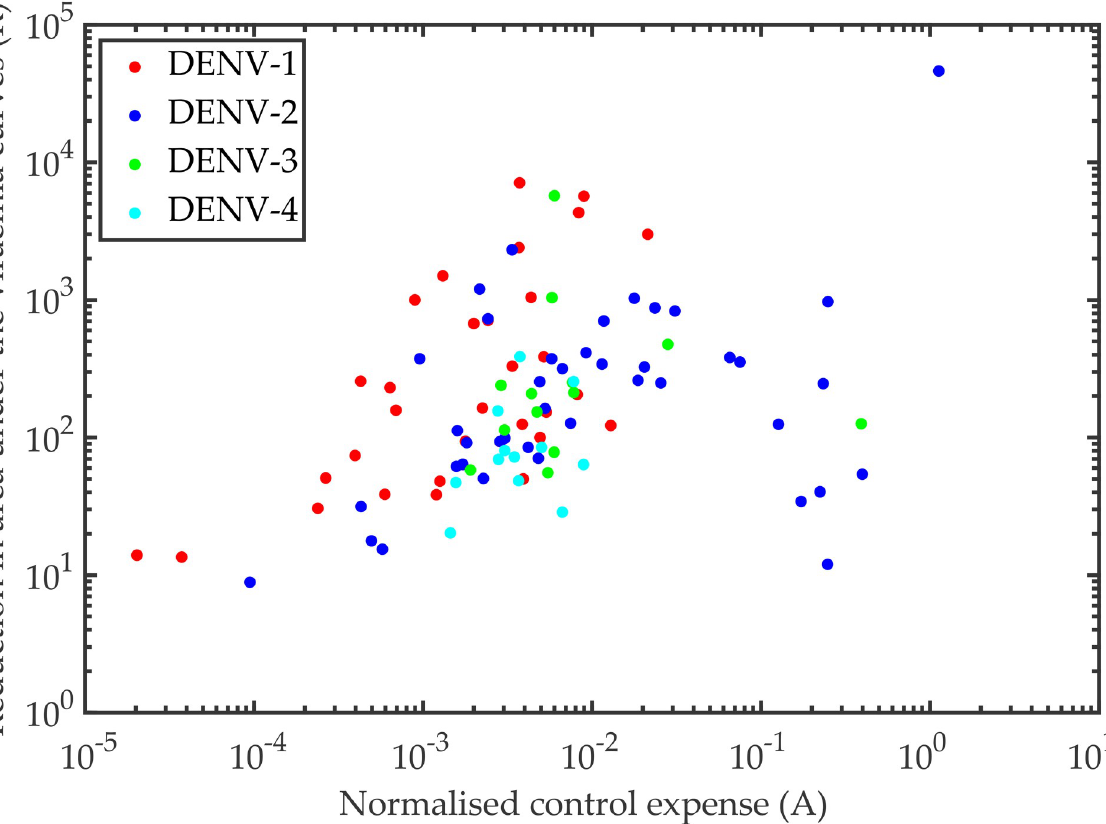
Fig 9. Control efficiency. The efficiency of the intervention strategy using bang-bang control is evaluated here. The control expense (A), which is the area under the control ( u ( t )) curve, represent the expense of the treatment for the corresponding patients, who responded with a (R) fold reduction in their corresponding viraemia peak. The (R) fold reduction in the viraemia peak is plotted with respect to the normalised control expense (A) for the four serotypes, DENV-1 (red), DENV-2 (blue), DENV-3 (green), DENV-4 (cyan).